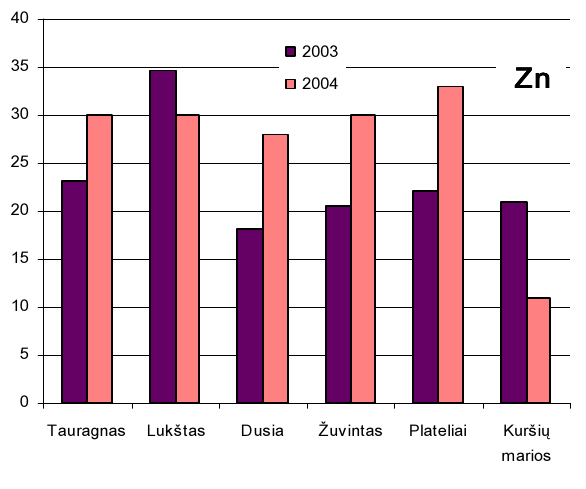
Fig. 6. Dynamic of heavy metal (Zn) concentrations (mg/kg) in perch and roach muscles from monitored water